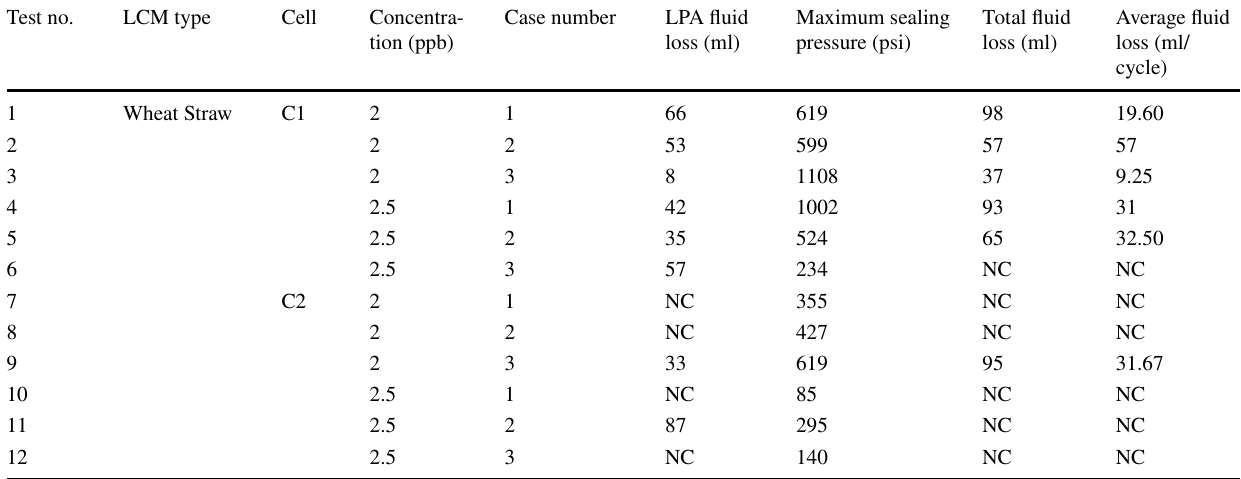
Table 8 Summary of HPA testing results for Wheat Straw Test